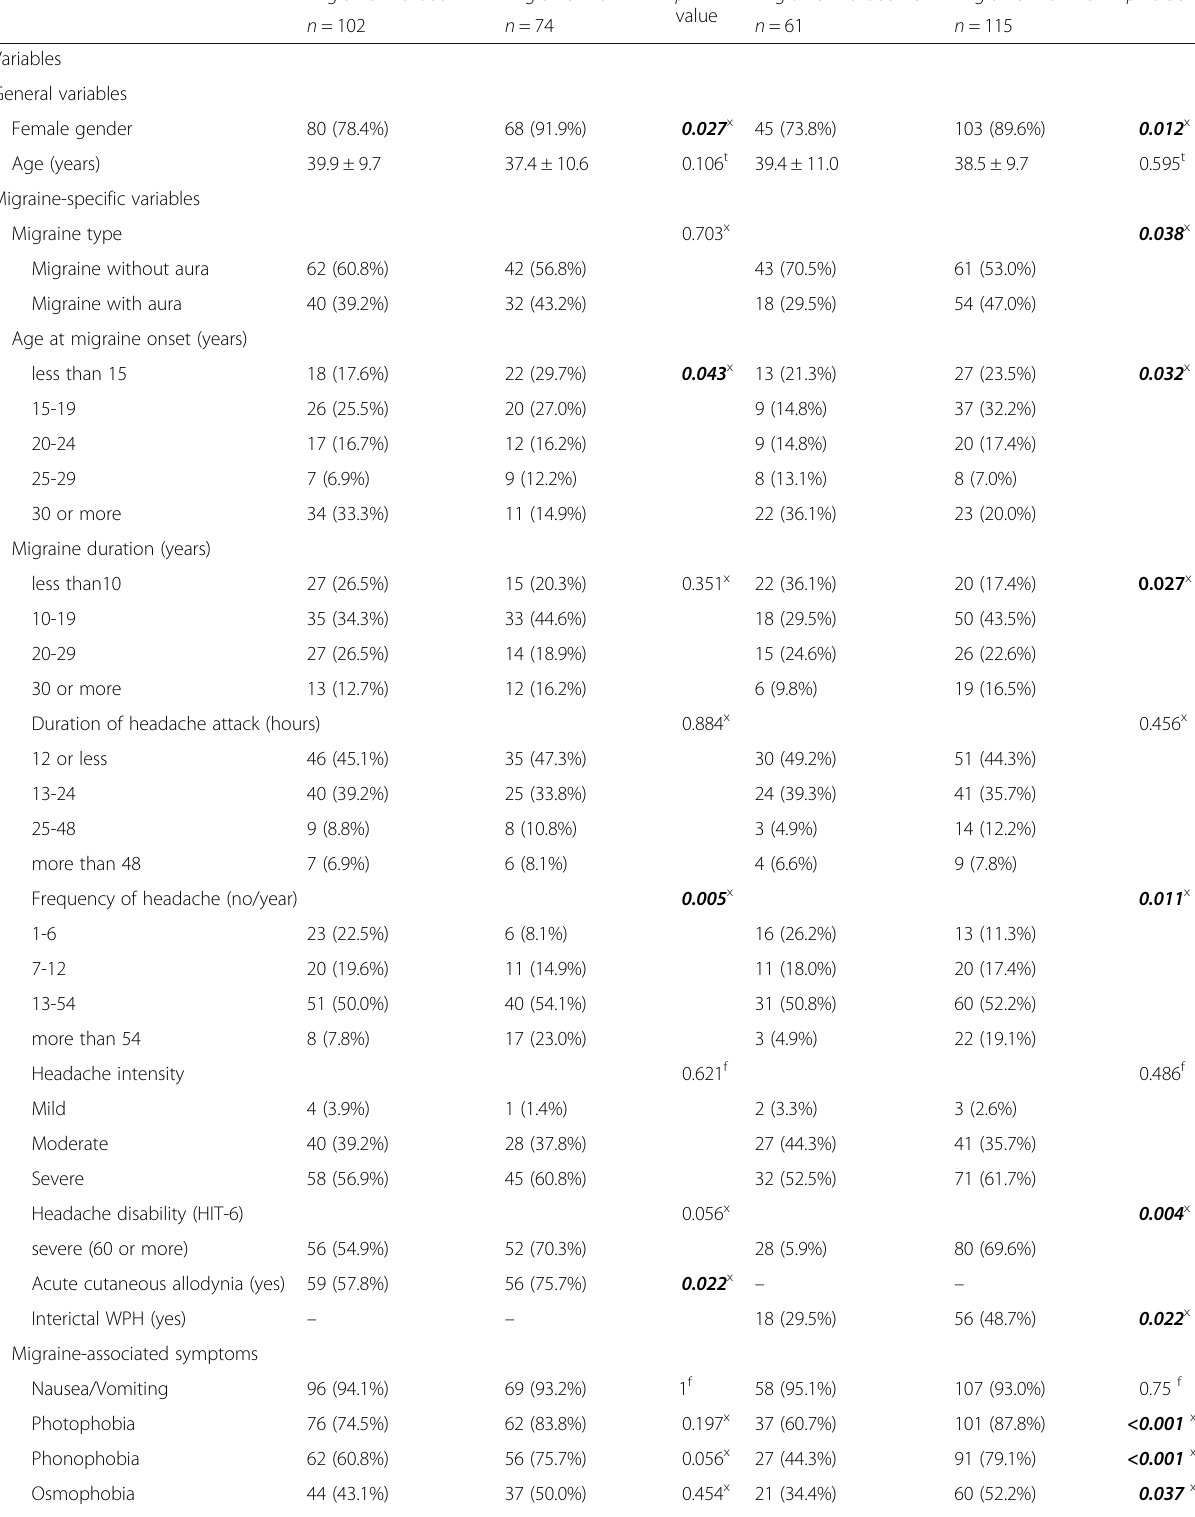
Table 3 Baseline characteristics of 176 migraine patient, separated by the presence of interictal widespread hyperalgesia (left) and acute allodynia